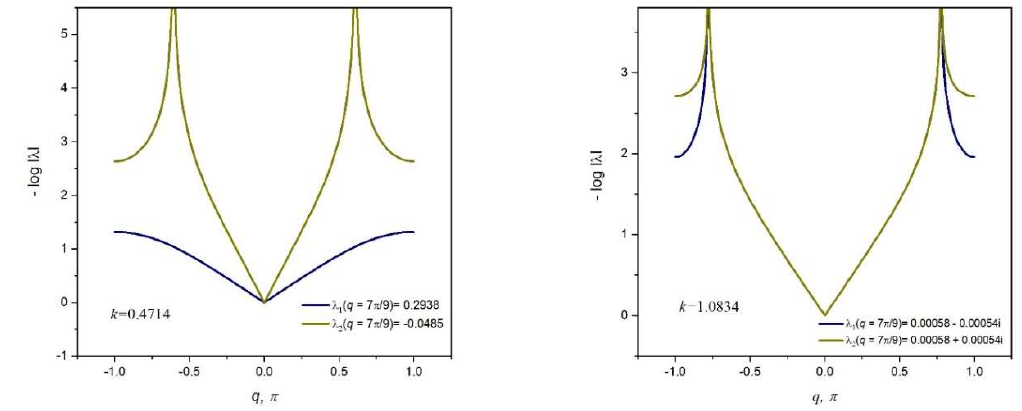
Figure 11. Deformation decay spectrum for k = 0.4714 and k = 1.0834, respectively.